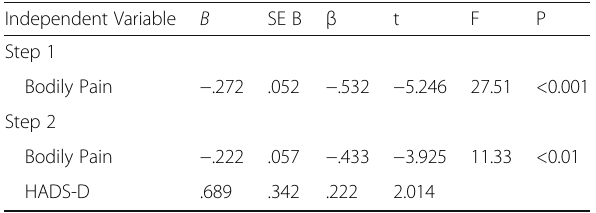
Table 2 Summary of Stepwise Regression Analyses to Determine Baseline Predictors of the Emotional Burden